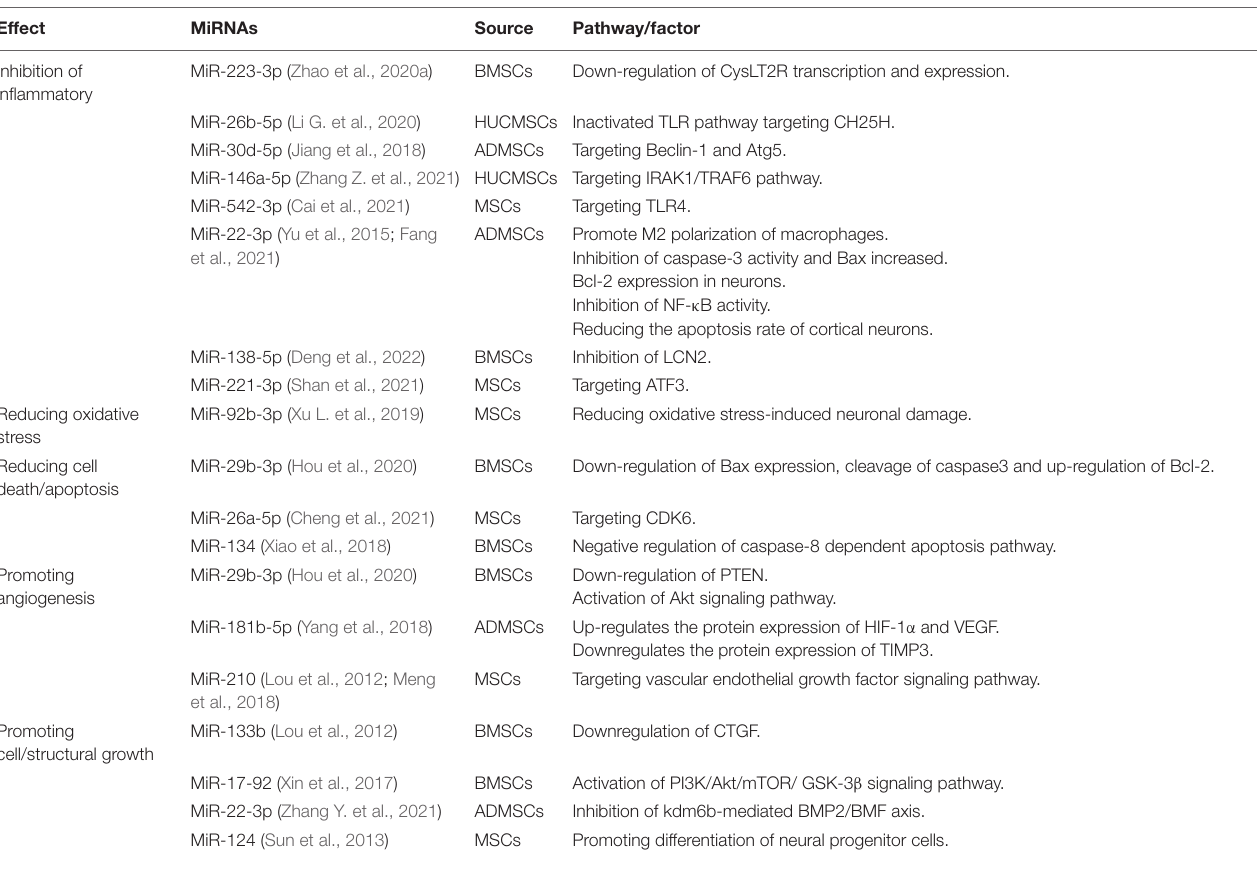
TABLE 2 | MiRNA regulates pathophysiology of ischemic